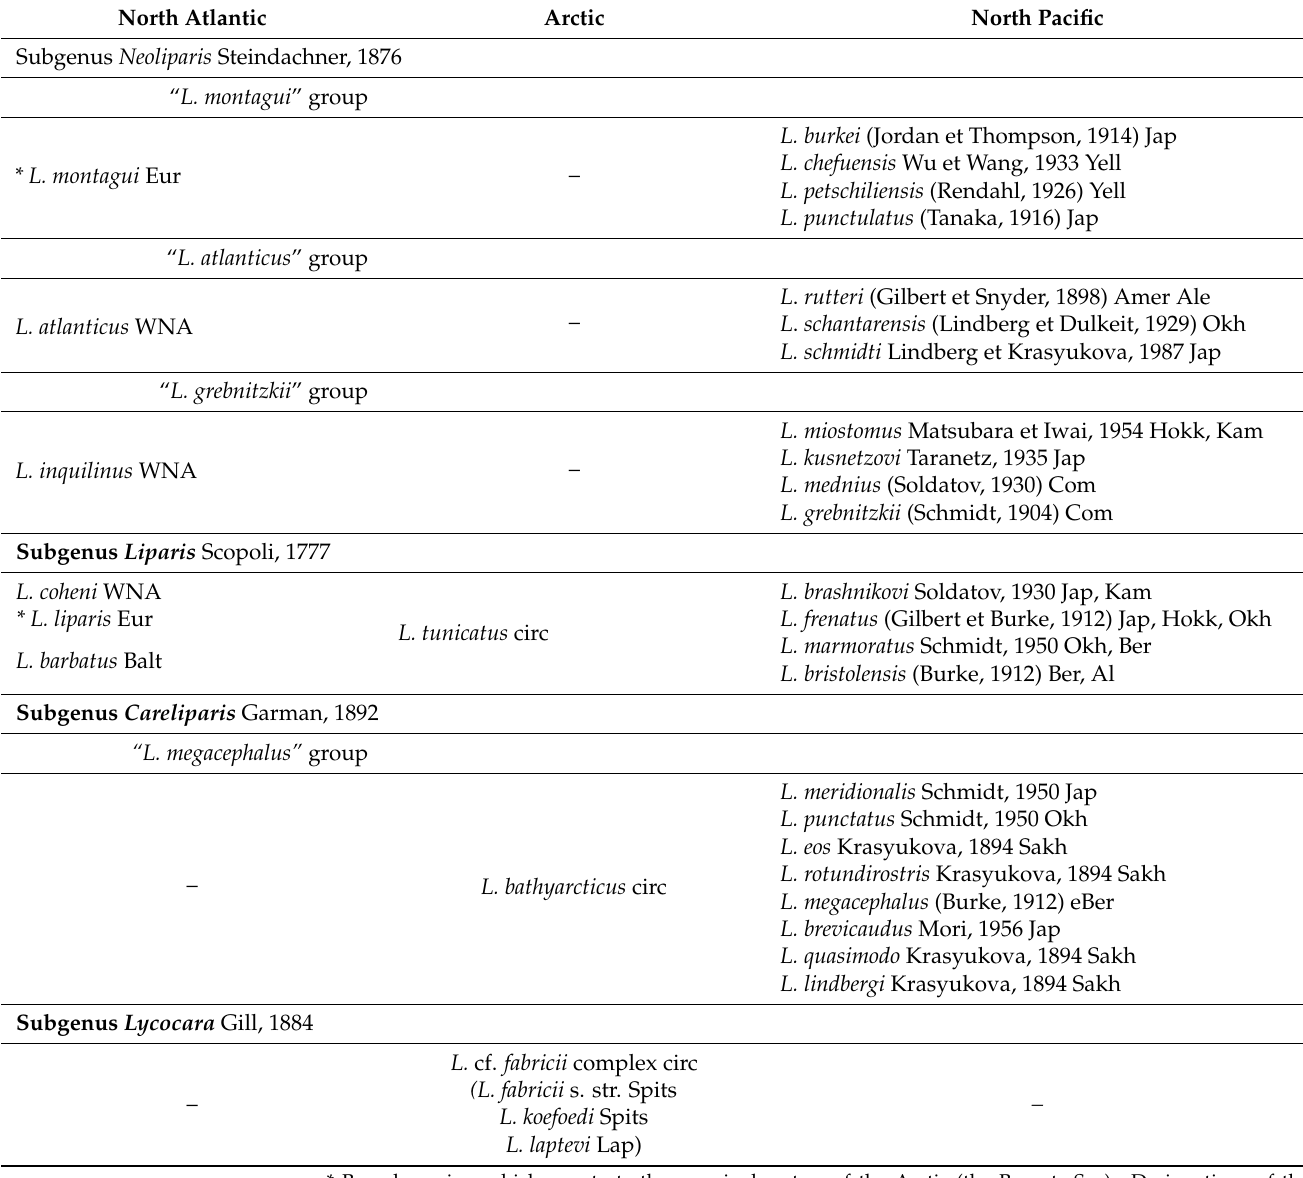
Table 4. Groups of Liparis with amphiboreal and boreal–Arctic